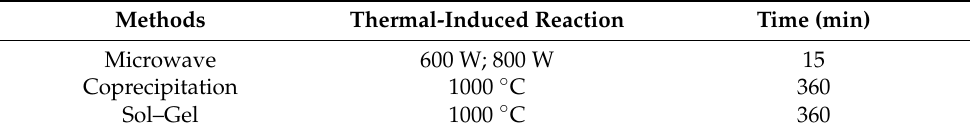
Table 3. Hydroxyapatite conversion by microwave, coprecipitation, and sol–gel